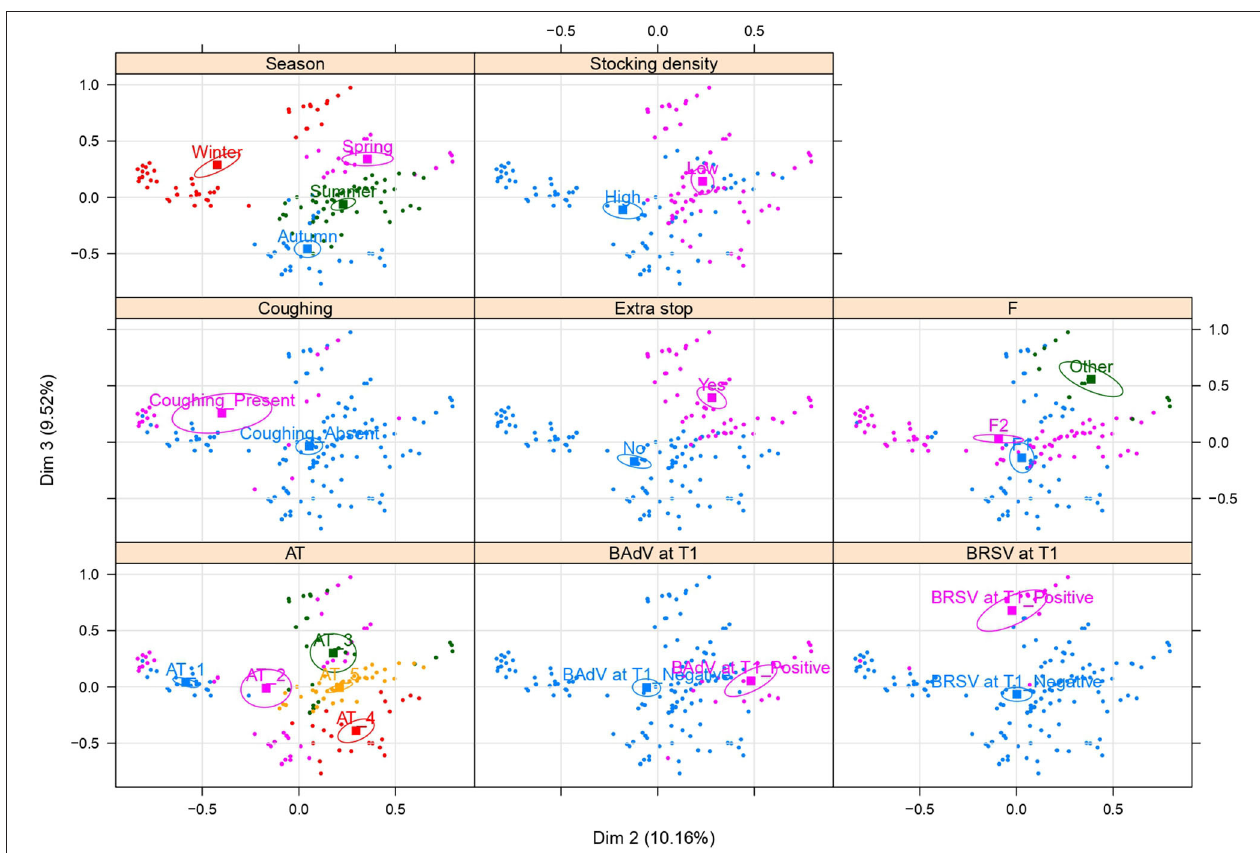
FIGURE 3 | The multiple correspondence analysis (MCA) biplot with Dimension 2 (Dim2) as x-axis and Dimension 3 (Dim3) as y-axis, with the explained variance between brackets. Different colors and confidence ellipses are drawn for the main variables entering the first two dimensions and explaining most of the variance noticed in the sample of 169 beef steers transported with a long-distance journey from France to Italy. F, farm of arrival; AT, arrival